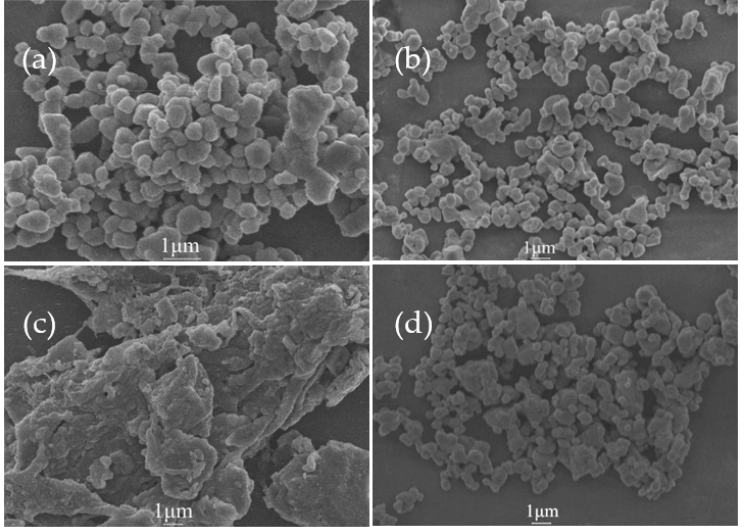
Figure 8. AlN powder SEM diagram: ( a ) original AlN powder; ( b ) modified AlN powder; ( c ) original AlN after 1 h of hydrolysis; ( d ) modified powder after 10 h of hydrolysis.